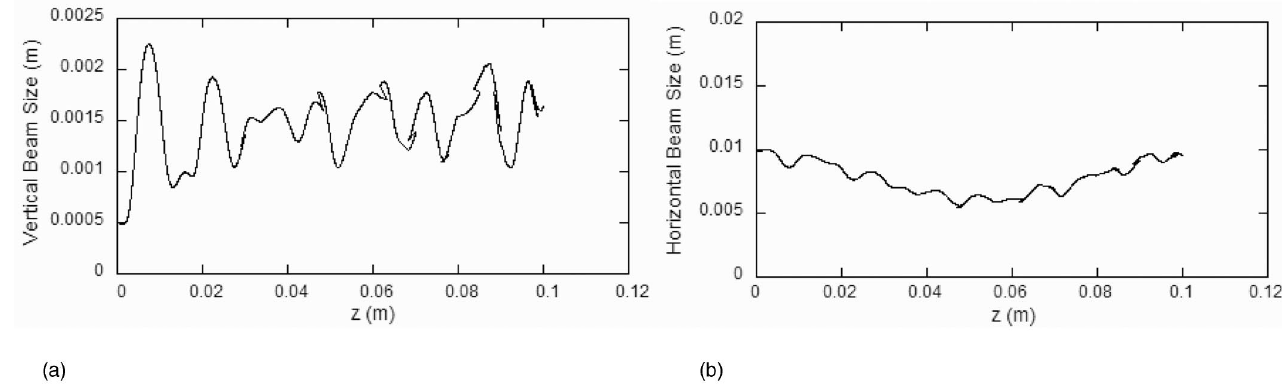
FIG. 6. Nominal two-plane focusing case for PPM focusing, with peak field of 0.291 T and a wave number ratio of 0.375. (a) Vertical beam size versus axial position. (b) Horizontal beam size versus axial position.